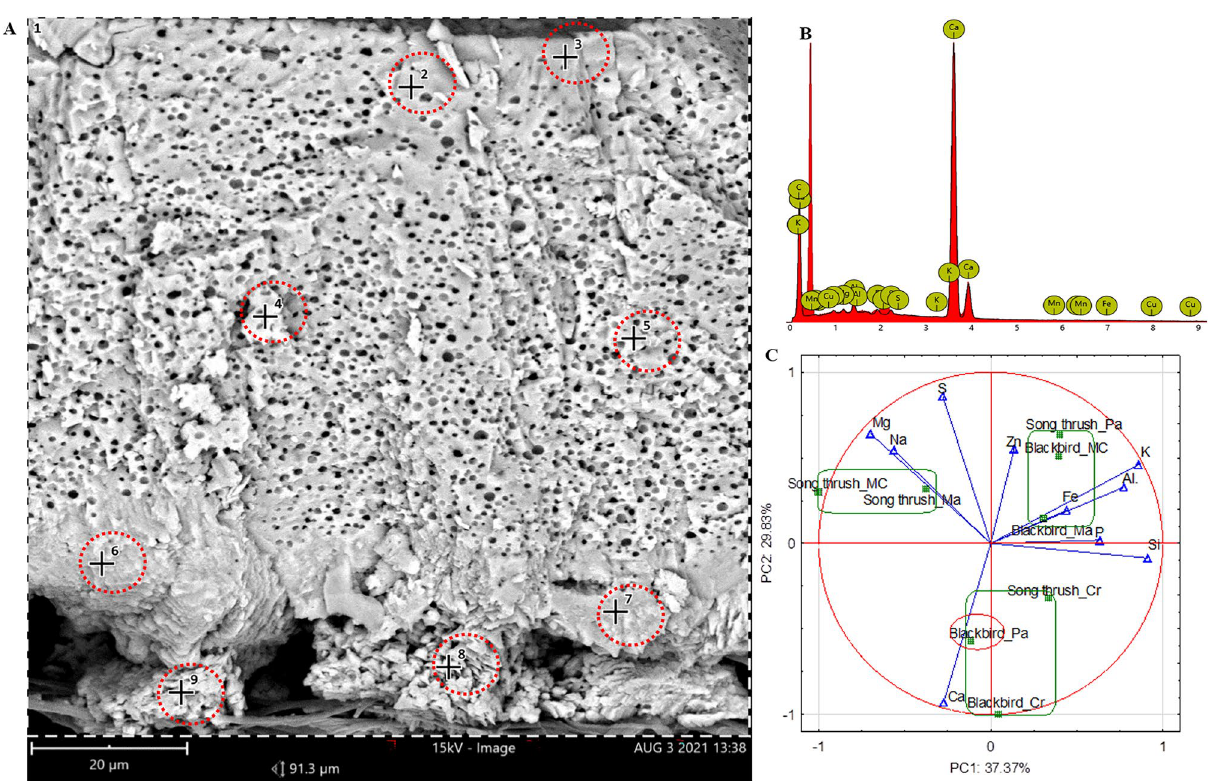
Figure 7. Comparative analysis of elemental content in different layers of blackbird and song thrush eggshells. Micrograph ( A ) shows the measurement sites and ( B ) shows exemplary spectra of the elements from the SEM–EDS analysis. Diagram ( C ) provide the results of PCA, in which PC1 and PC2 are the first two principal components.